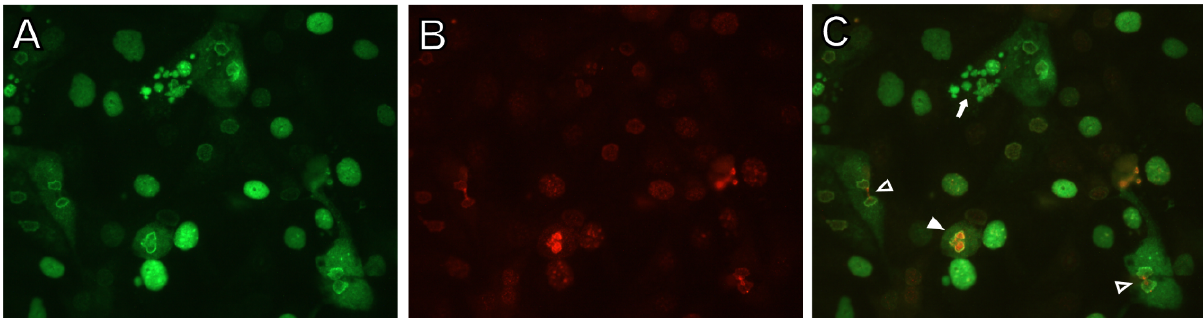
Figure 6. Abnormal mitotic events in LY2603618-treated BKPyV-infected cells. Quiescent RPTECs were infected with BKPyV Gardner (MOI = 10 IU/cell) for 1.5 h. The inoculum was removed and culture medium containing 4 µM LY2603618 DMSO was added. Cells were fixed at 3 dpi. Cells were first incubated with combined primary antibodies, rinsed and then incubated with combined secondary antibodies. ( A ) Anti-TAg (Pab416) and Alexa 488 goat anti-mouse IgG; ( B ) anti-pH3- Ser10 and Alexa 594 goat anti rabbit IgG; ( C ) merged TAg and pH3-Ser10 images. Open arrowheads: pH3-Ser10-stained intercellular bridges in telophase cells; filled arrowhead: A single cell containing two connected TAg and pH3-Ser10-stained chromatin masses; filled arrow: TAg-stained fragmented nuclei. (40× objective).